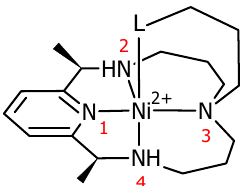
Figure 3. General representation of Ni(II)–PyMAC complex. Nitrogen atoms are numbered accordingly. L stands for the part of the pendant arm that coordinates axially to the Ni metal center.